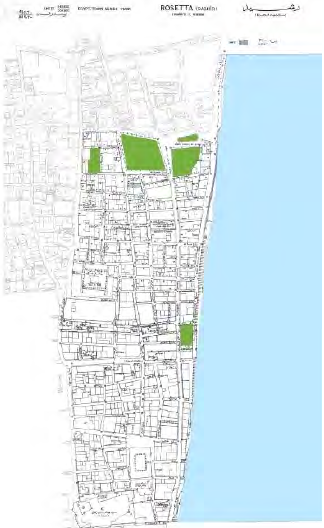
Figure 9. (Rashid public parks